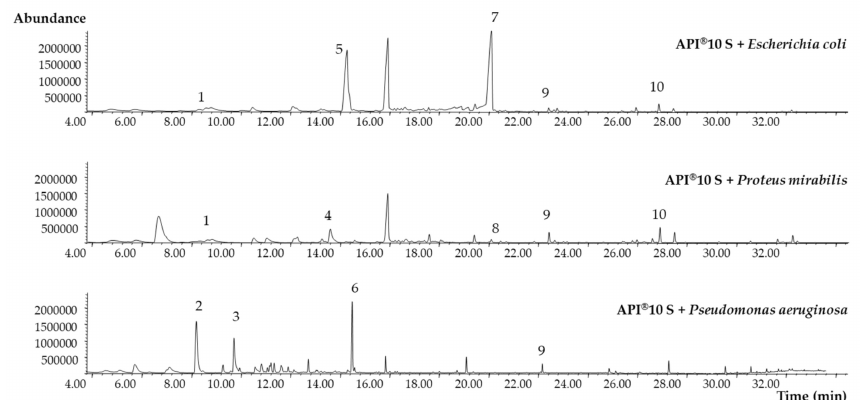
Figure 6. Identified MVOCs in the obtained SPME-GC-MS chromatograms after API ® 10 S inoculation. See the numbers’ correspondence in Table